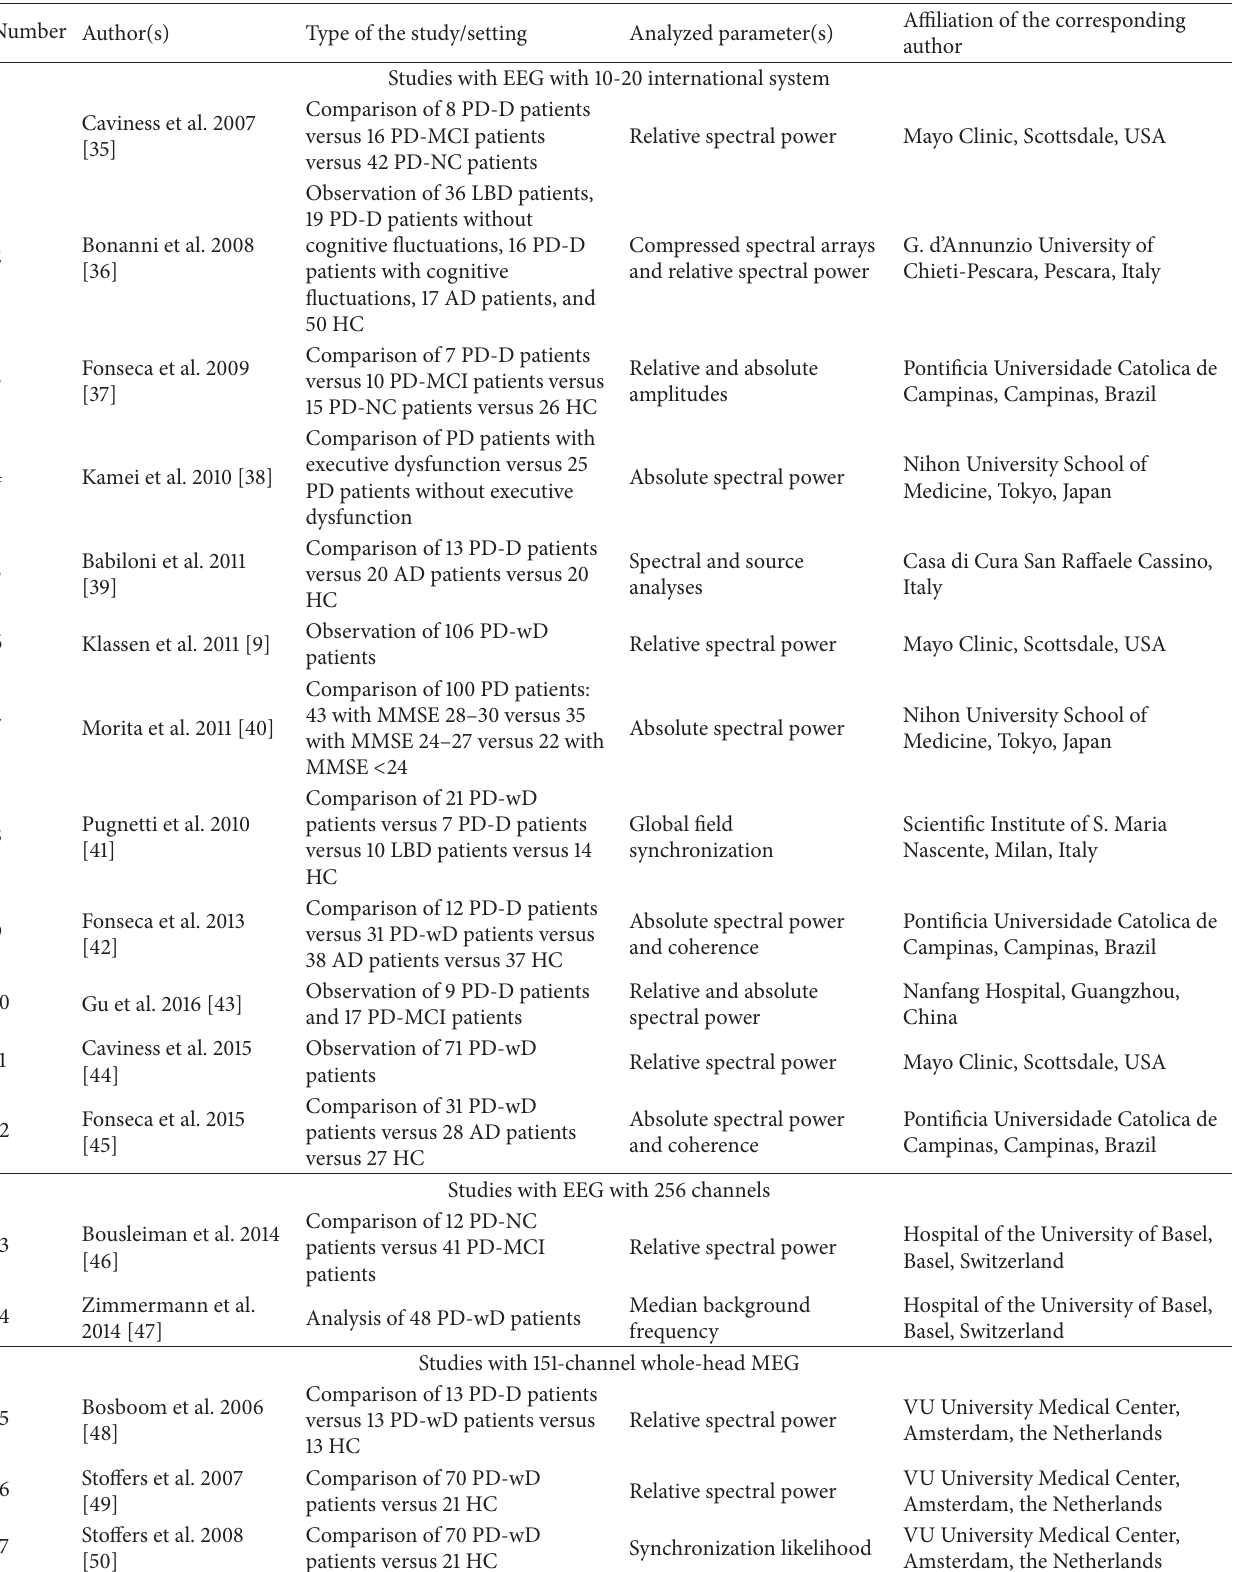
Table 1: Profiles of the studies, which met the inclusion